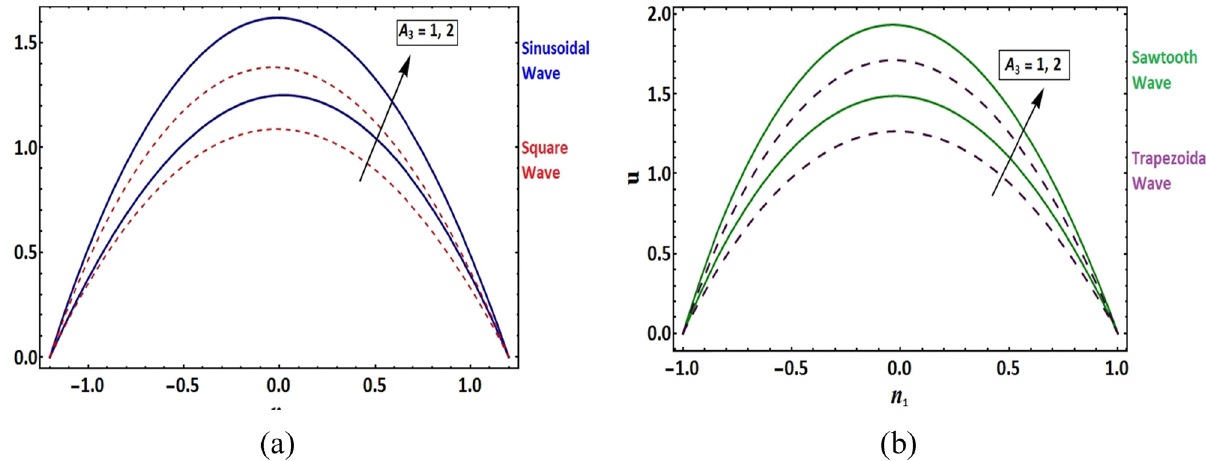
= 0.1, Sc = 0.5, A = 2, Sr = 0.5, K = 3, Br = 0.5, K 1 1